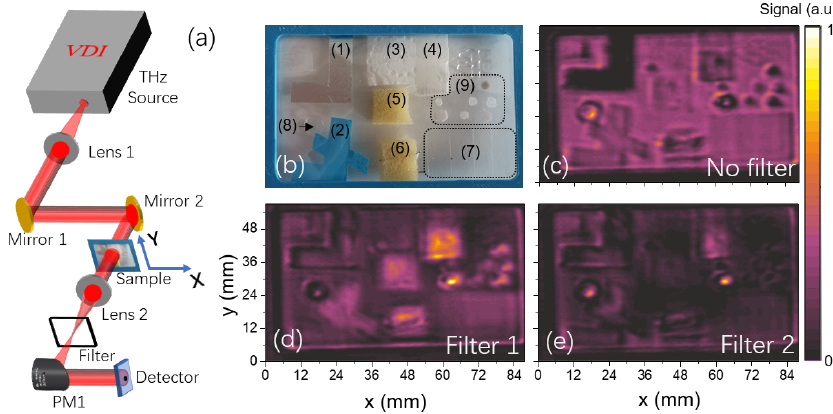
Figure 7. Principal scheme of phase contrast imaging set up for 0.3 THz, where L1—HDPE lens with f = 12 cm, M1, M2—gold plated flat mirrors, sample, L2—TPX lens with f = 6 mm, Filter—(1): (cid:11) = 2 mm circle shaped four paper sheets, (2)— (cid:11) =2 mm circle shaped aluminum foil, PM1—off axis parabolic mirror with f = 5 cm ( a ). Photo of the sample with plastic substrate film, it consists of: (1)—metal, (2)—rubber, (3)—paper towel, (4)—napkin, (5)— sponge, (6)—sponge with metal wire inside, (7)—plastic (from 1 to 4 layers), (8)—aperture (diameter: 4 mm), (9)—dots, made of silicone, acrylic and wax ( b ). Direct raster scan image of the sample at 0.3 THz ( c ) . Phase contrast images obtained using filter 1 ( d ) and filter 2 ( e ). THz image pixel size: 0.3 mm × 0.3 mm; images consist